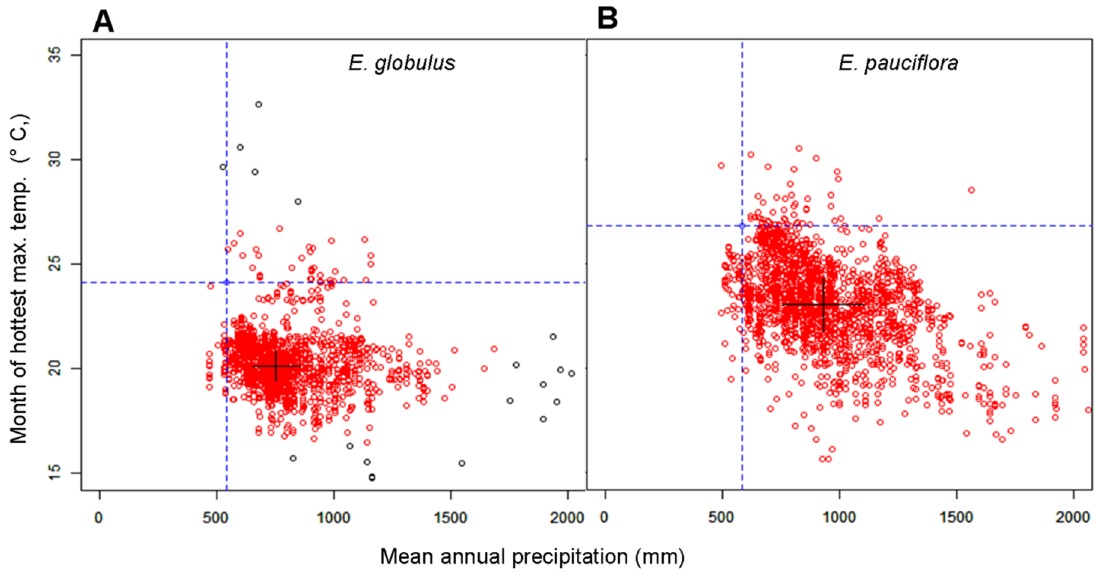
Figure 1. Scatter plot of mean annual precipitation (MAP) versus maximum temperature of hottest month (MTHM) for all recorded species locations for ( A ) Eucalyptus globulus and ( B ) E. pauciflora . The solid vertical and horizontal lines denote the interquartile range and the dashed blue lines denote the 0.02 and 0.98 percentile for MAP and MTHM respectively. Black symbols denote outliers, that weren’t included in calculations of climatic indices, whereas red symbols were included in the